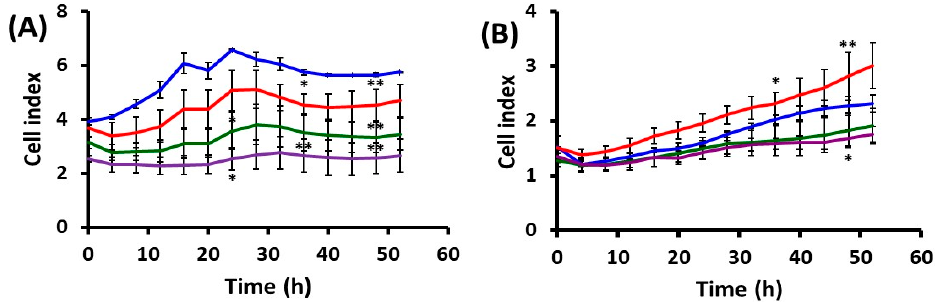
Figure 2. Kinetics of cell adherence, spreading and proliferation for keratinocytes after UVA irradiation on 5 µg/mL collagen. ( A ) HaCaT; ( B ) DOK; blue plots—mock-irradiated cells; red plots — 15 min irradiation; green plots—30 min irradiation; purple plots—60 min irradiation. * p < 0.05, ** p < 0.01.